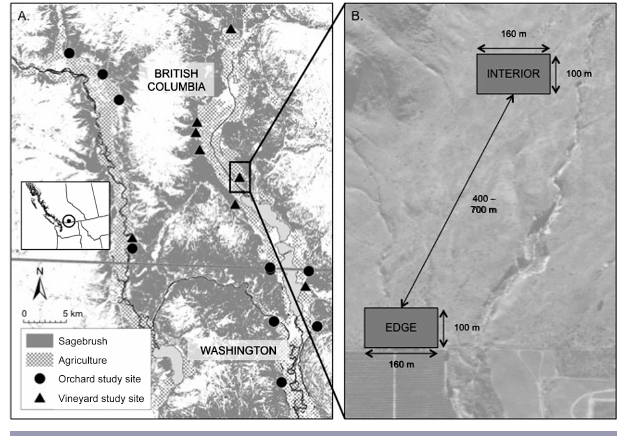
study site consisted of a pair of study plots: one plot adjacent to agriculture (edge) and one away from agriculture